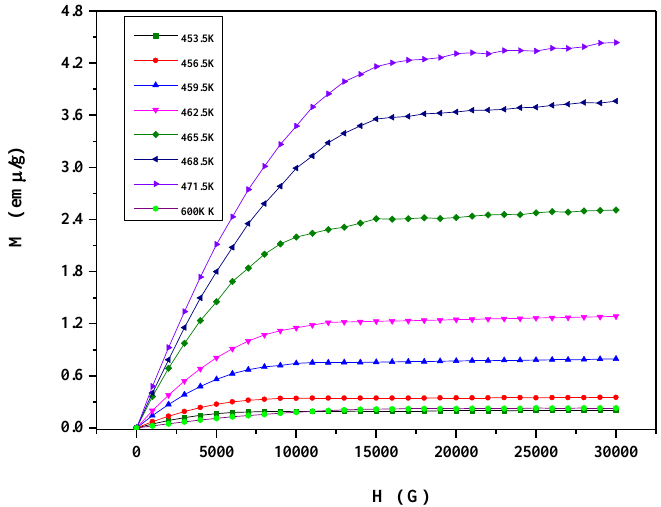
= 0.540) alloy. Materials 2020 , 13 , x FOR PEER REVIEW 1 − x Ni x In 2 (x